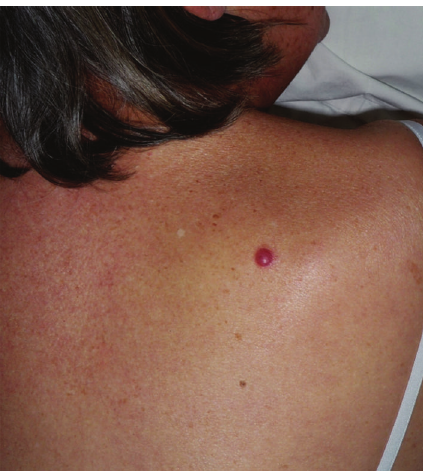
Figure1:Seethesolitaryanderythematousnoduleof1 cmindiame- ter on the patient’s back.